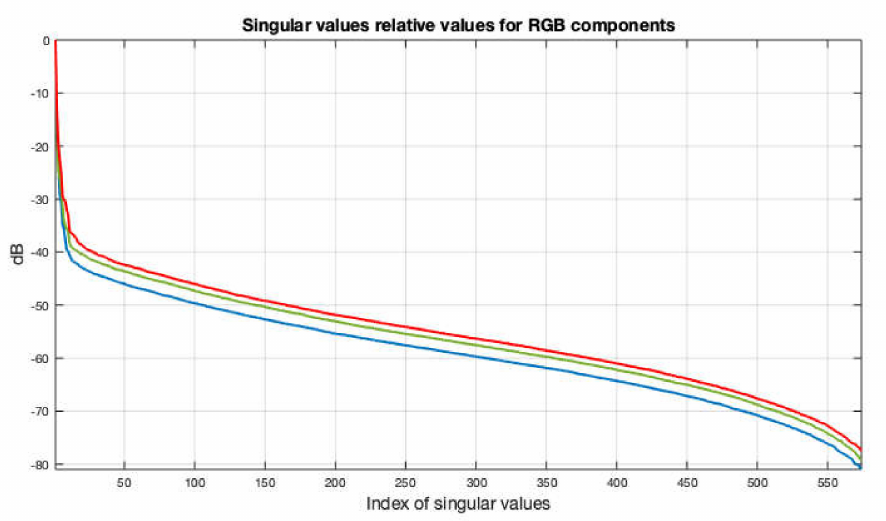
Figure 1. Singular values of a generic skin lesion image under test. The three curves refer to Red, Green, and Blue color component in the